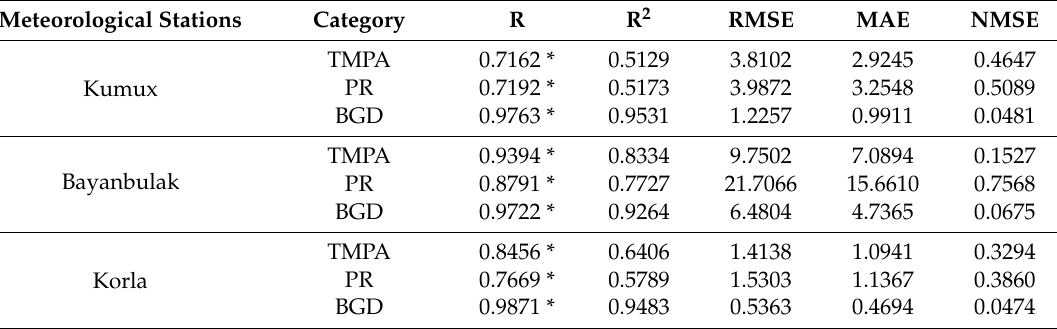
Table 2. Comparing the TRMM (Tropical Rainfall Measuring Mission) Multi-Satellite Precipitation Analysis (TMPA) and downscaling results based on observation